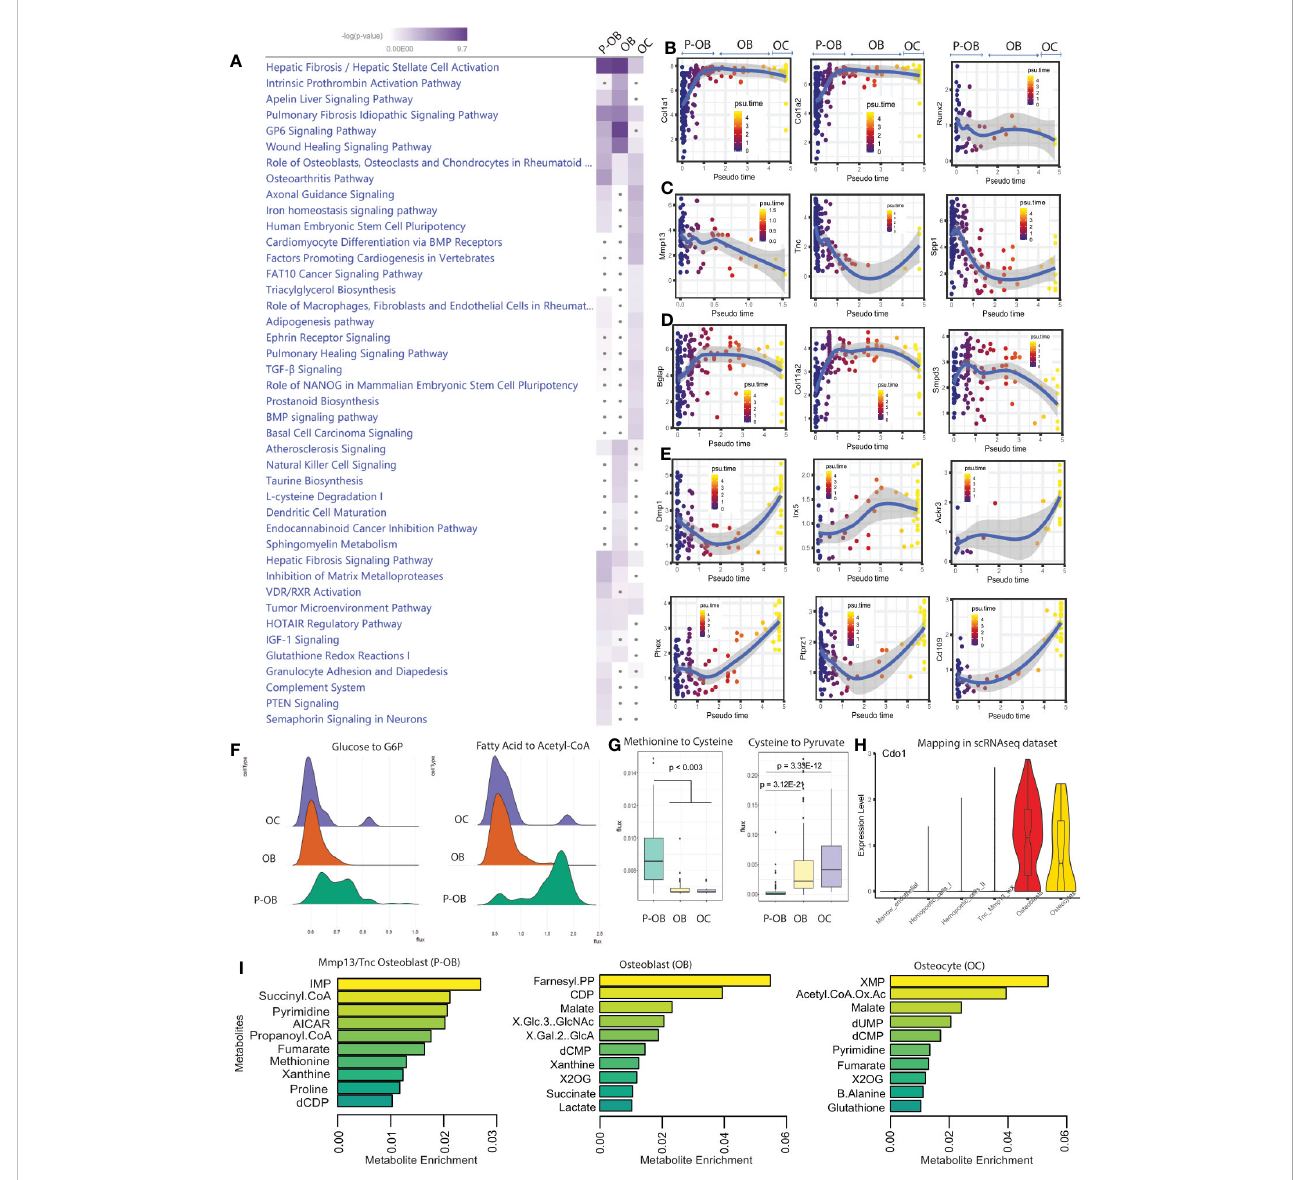
FIGURE 2 Differential signaling pathways in osteoblasts versus osteocytes. (A) . Ingenuity Pathway Analysis (IPA) software was used to predict the statistically signi fi cant canonical pathways upregulated in Tnc/Mmp13 osteoblasts (P-OB), osteoblasts (OB) and osteocytes (OC) from the scRNAseq data based upon a calculated probability score of ≥ 2 and a p-value of <0.05. Further, a comparative analysis between osteolineage cells was performed to generate the heatmap. The increase of blue intensity re fl ects the more signi fi cant pathways within cell types. The gray dots indicate non-signi fi cant pathways. (B – E) . Monocle analysis shows pseudotime trajectory mapping of osteolineage gene sets Col1a1, Col1a2, Runx2; pre-osteoblast gene sets Mmp13, Tnc, Spp1; osteoblast gene sets Bglap, Col11a2, Smpd3; and osteocyte gene sets Dmp1, Irx5, Ackr3, Phex, Ptprz1 , and Cd109 . (F) . The computational method scFEA was used to infer cell-wise fl uxome from the scRNAseq data to predict the metabolic pro fi ling as well as the differential metabolite conversion rate in cells that correspond to a metabolic fl ux value. Ridgeline plots indicate the distribution values of metabolic fl ux in Tnc/Mmp13 osteoblasts (P-OB), osteoblasts (OB), and osteocytes (OC). Each ridgeline represents the fl ux between two metabolites, shown on the x-axis, for different osteolineage cells, shown on the y-axis. (G) . Violin plot displaying Cdo1 expression in scRNAseq dataset. (I) . The boxplots indicate the predictive value of the conversion of methionine to cysteine and to pyruvate in P-OB, OB, and OC. (H) . The bar plots show the top 10 different metabolites enriched in P-OB, OB, and